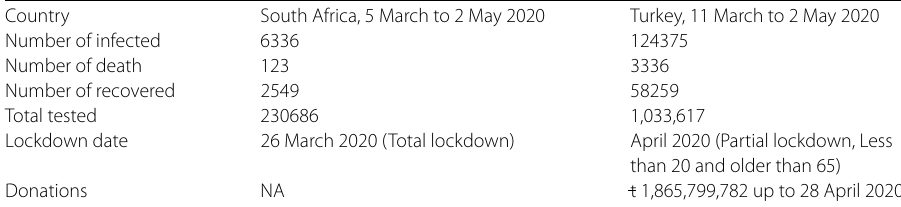
Table 5 Comparison between Turkey and South Africa updated on Covid-19